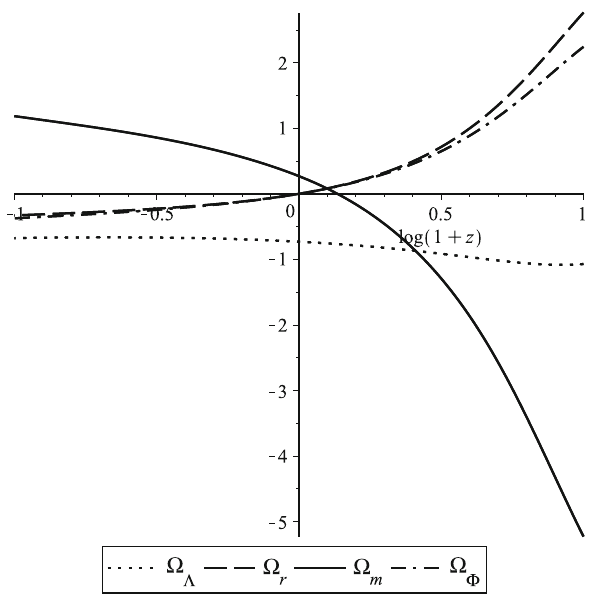
Fig. 1 Numerical solutions for density functions for the set of param- eters b = 0 . 5, w (cid:16) = − 1 / 3 ; w φ = 0. Here, the horizontal axis shows log ( 1 + z ) and the vertical axis shows the value of the density